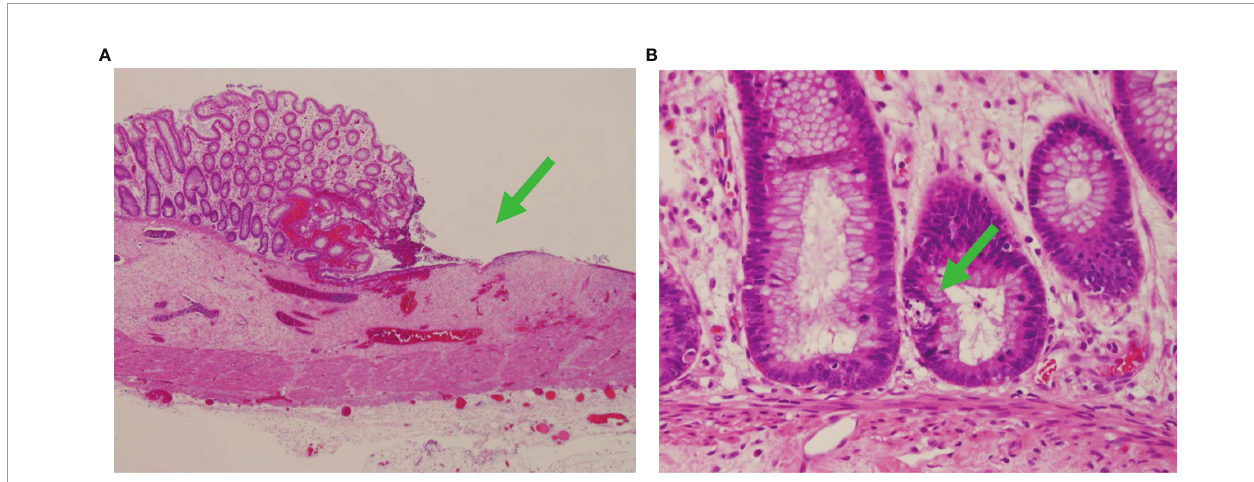
FIGURE 1 | Autologous graft-versus-host disease in the colon. Fragments of colon tissue from the patient demonstrating diffuse subtotal loss of mucosa with marked epithelial apoptosis (green arrows) and intermittent ulcers, consistent with severe autologous graft-versus-host disease. (A) ×40 and (B) ×400 magni fi